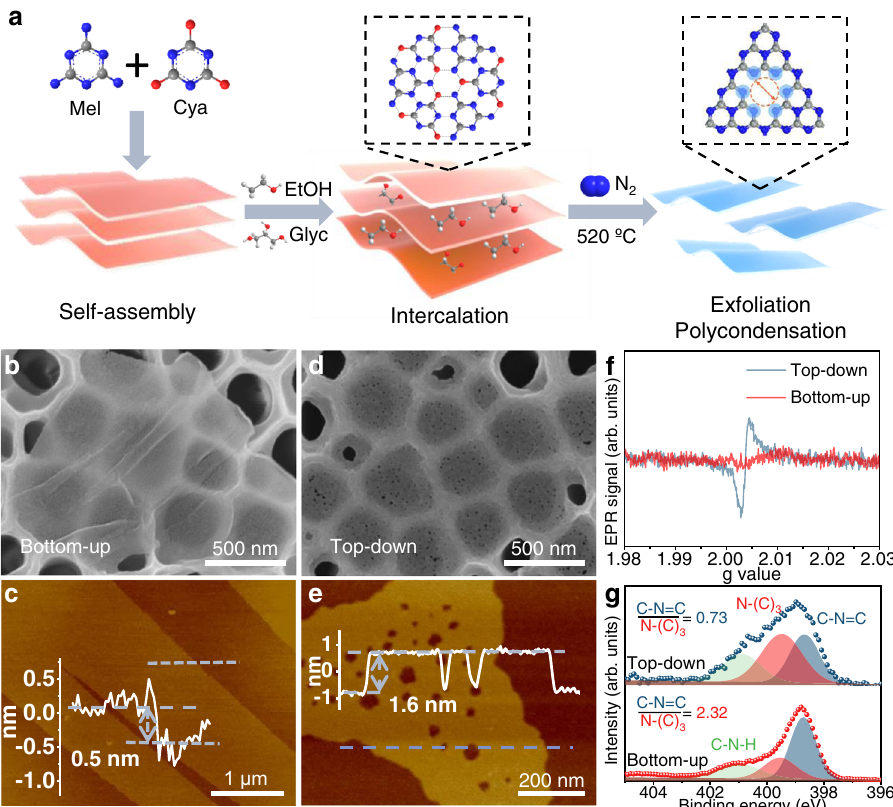
Fig. 1 | High-quality g-C 3 N 4 nanosheets. a The fabrication process of g-C 3 N 4 nanosheets. Step 1: The melamine (Mel) and cyanuric acid (Cya) were self- assembled into layered supramolecular precursors under hydrothermal condi- tions. Step 2: Through intercalation of an ethanol (EtOH)/glycerol (Glyc) mixture (3:1), the layerswereexpanded. Step 3:The g-C 3 N 4 nanosheetswere obtained viaa calcination process under nitrogen. C, N, O,and H atoms are colored in gray, blue,